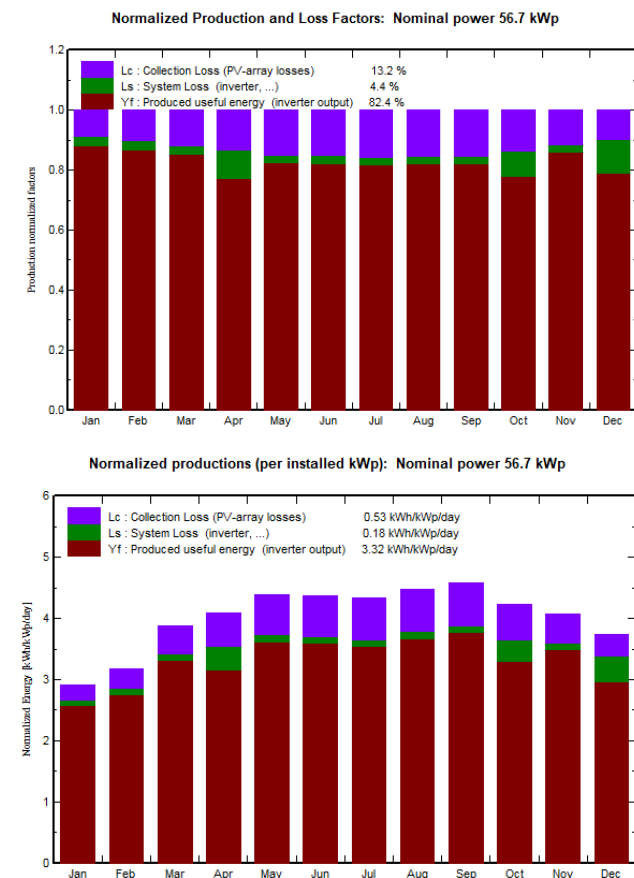
Figure 10. Types of losses versus output power It is can be seen that the generated power from the PV power system in Figure 11 corresponding to the solar radiation value. The time period from May to September has the highest power generation while January and February in the remaining months of the year have the lowest power output. On the other hand, the Global on tilted plane with the solar array slope angle of 18 0 is about 0.2 kWh/kWp/day higher than the case of GlobHor horizontal as shown in Figure 12. Total annual average electricity from the solar power station transmitting to the utility grid is 68625 kWh per Figure 9. Performance ratio